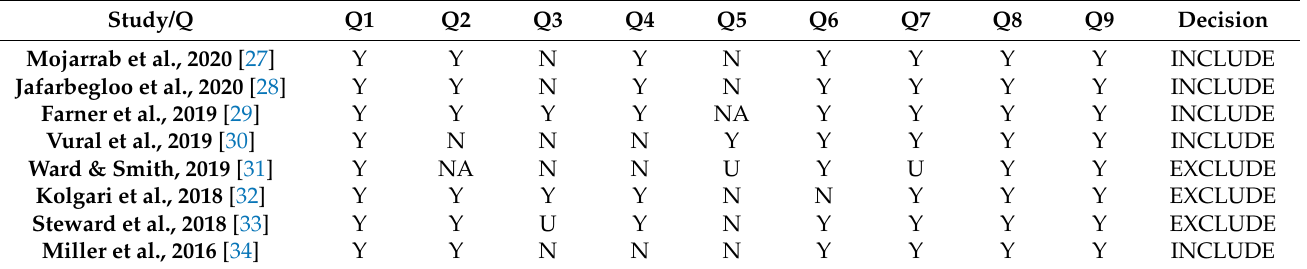
Table 2. Results of the Critical Appraisals for Inclusion or Exclusion of Quasi-Experimental